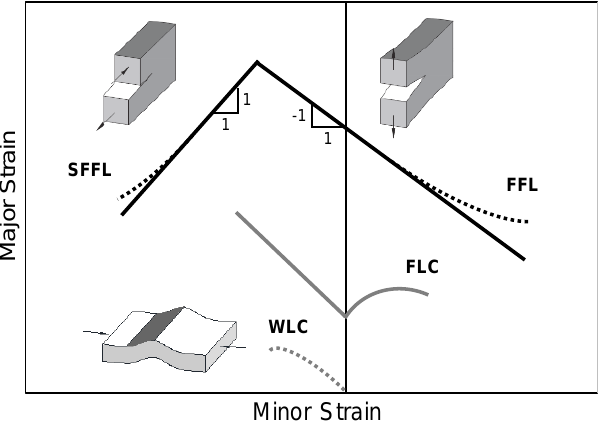
Figure 1. Schematic representation of the formability limits by necking, fracture (crack opening modes I and II) and wrinkling in sheet metal forming.